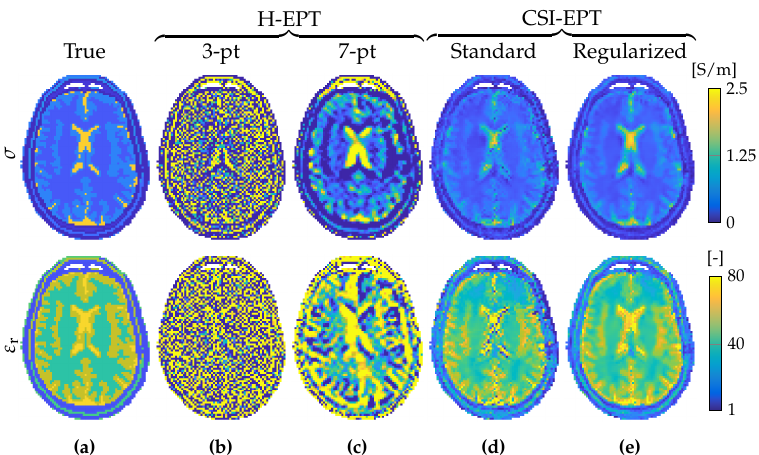
Figure 2. Direct differential method and forward integral method comparison on simulated three- dimensional noisy data (SNR = 100) from a 7 T head coil. Methods are three-dimensional implemen- tations without and with noise suppression in the form of using a larger differential kernel [32] or by including multiplicative total variation regularization [73]. True model ( a ), Helmholtz-based EPT with a 3-point kernel ( b ), Helmholtz-based EPT with a 7-point kernel ( c ), standard contrast source inversion EPT ( d ) and regularized contrast source inversion EPT ( e ). Conductivity (top row) and relative permittivity (bottom